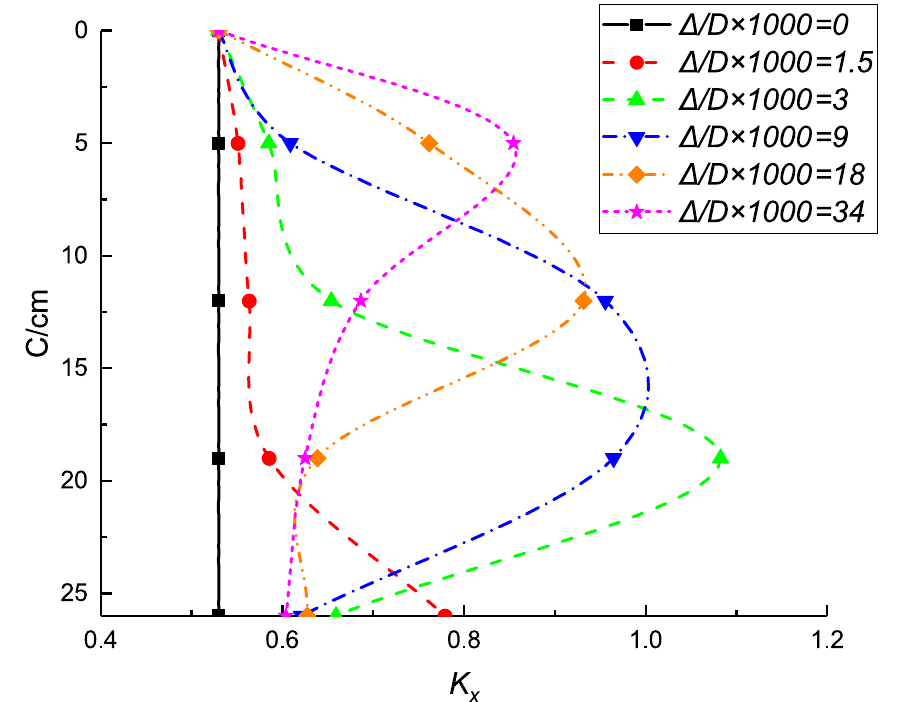
Figure 16. Variation in the horizontal lateral pressure coefficient during the test (without the pipe roof).